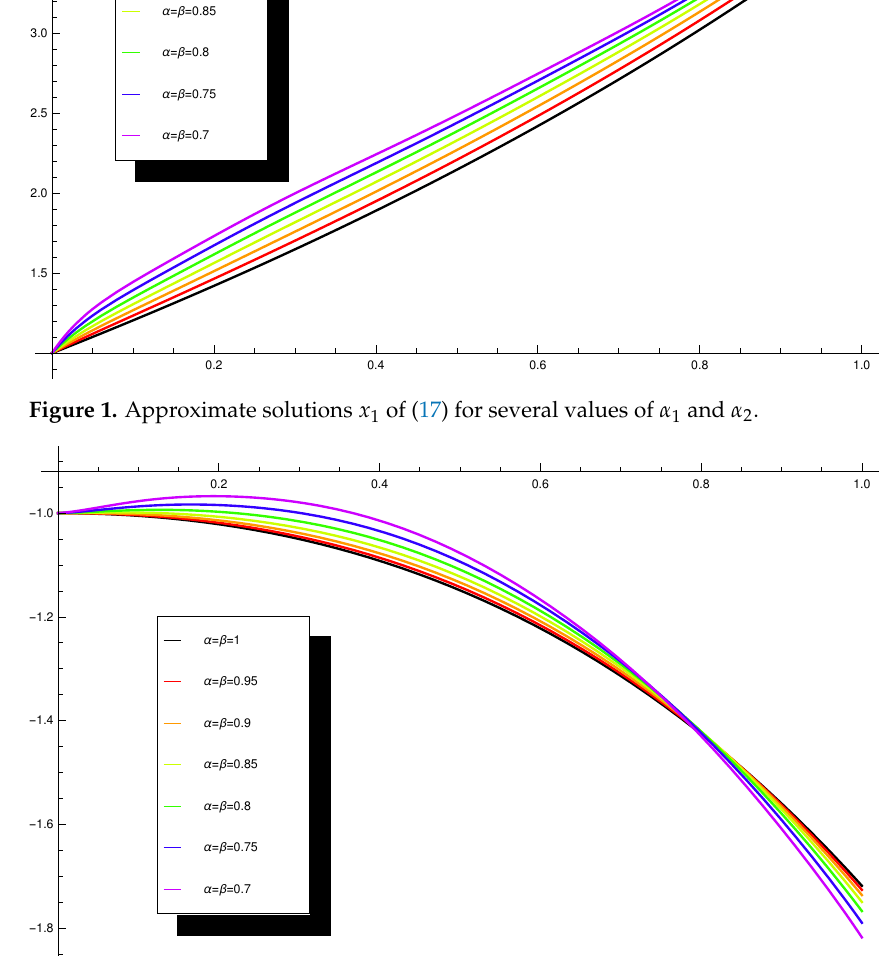
Figure 2. Approximate solutions x 2 of (17) for several values of α 1 and α 2